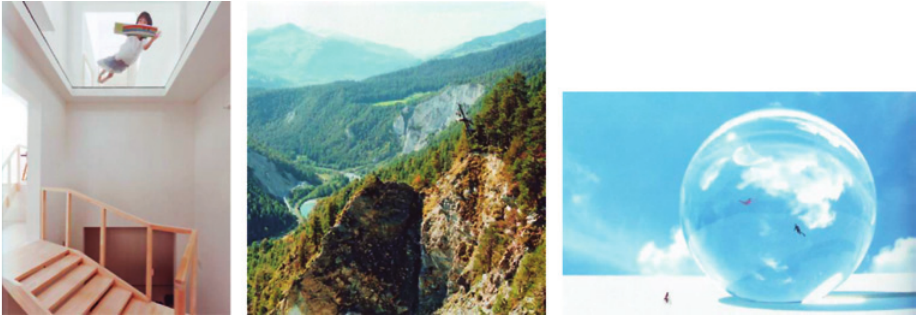
Fig. 37. Sou Fujimoto. Fig. 38. Corinna Menn. Fig. 39. Bernarda Silov, Davor Silov. CONN Viewing Platform. Atmosfera . Zagreb,